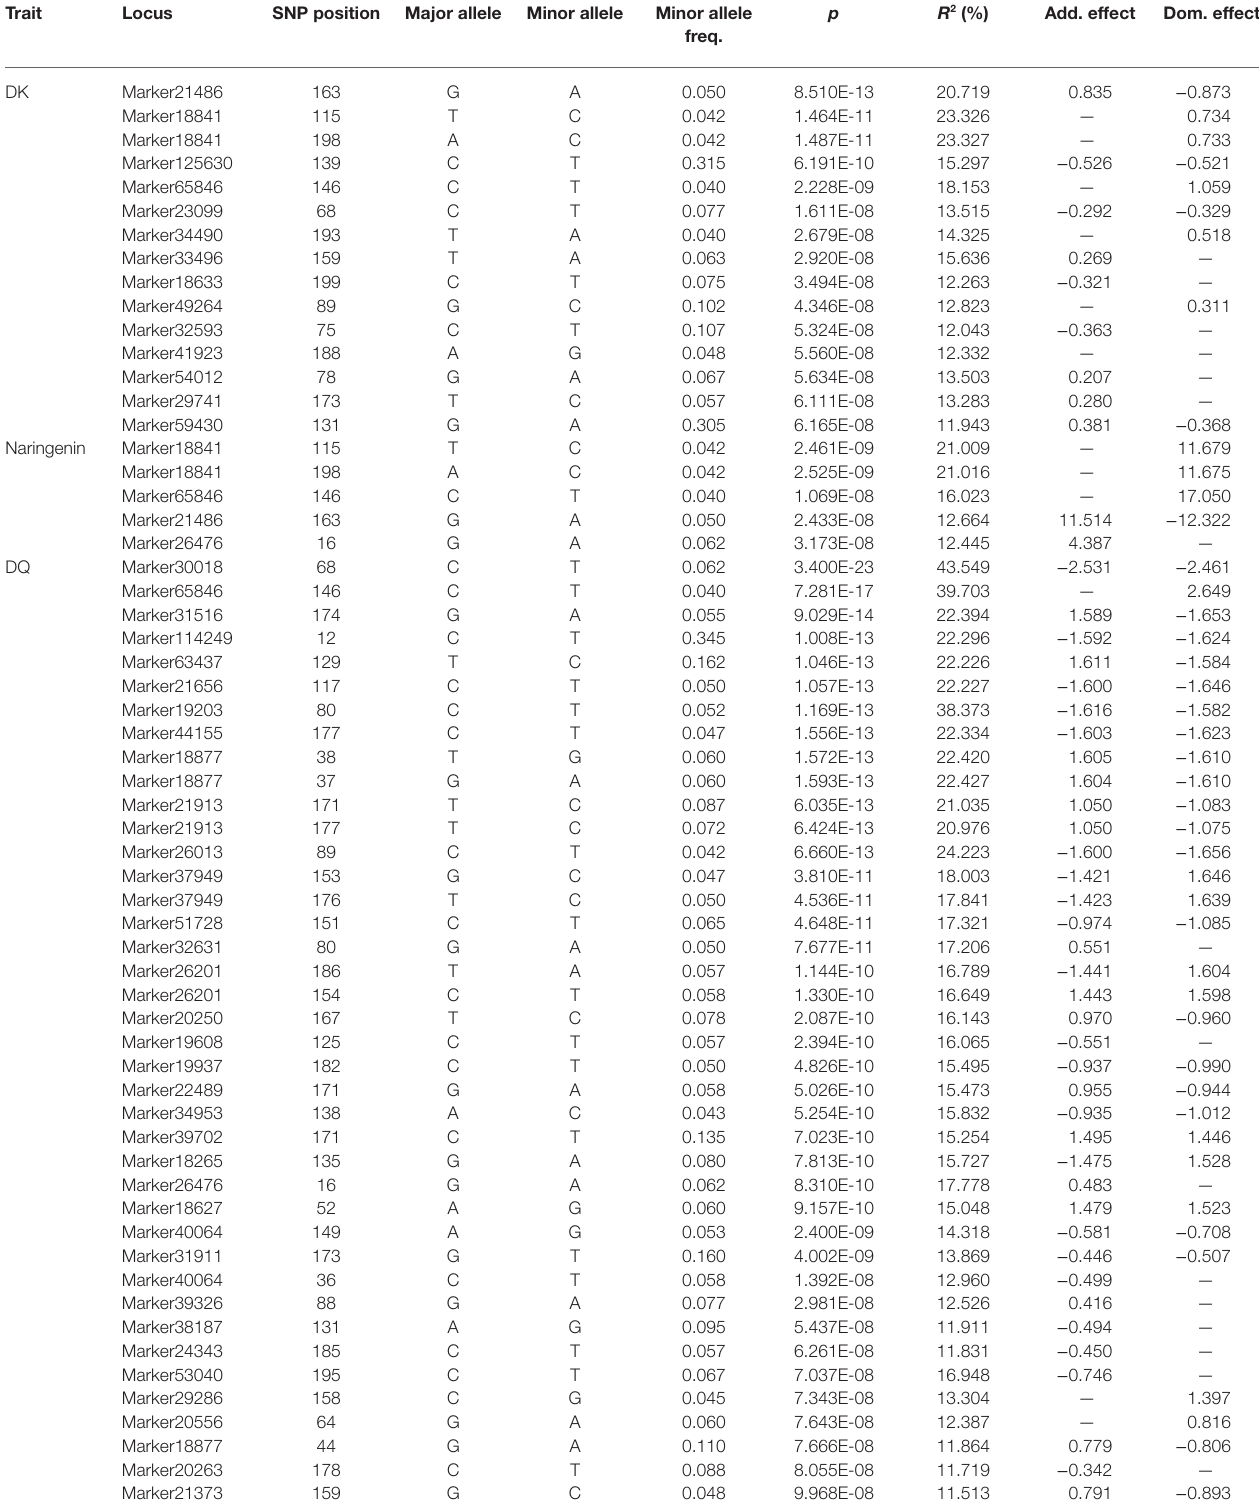
TABLE 4 | SNPs with significant association to flavonoid contents based on MLM GWAS. Trait Locus SNP position Major allele Minor allele Minor allele